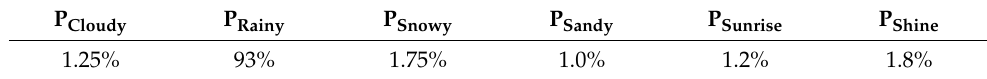
Table 1. Sample output of Softmax classifier.